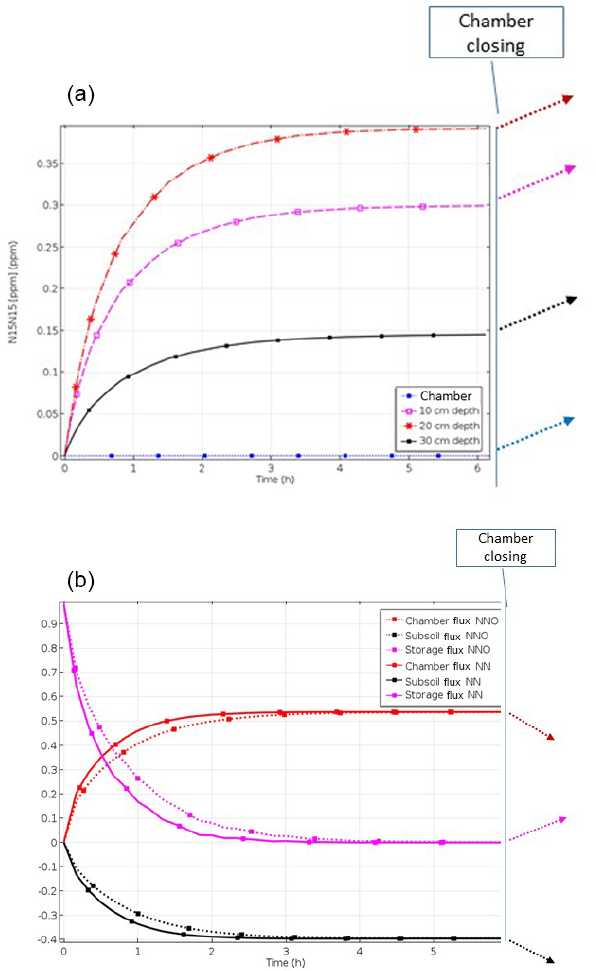
Figure 2. (a) Increase in pore space concentrations of N 2 evolved from the 15 N-labelled pool after start of denitrification, with open chamber when production of 15 N-labelled N 2 and N 2 O starts at constant rates, leading to accumulation of 15 N-labelled gases and thus build-up of concentration gradients to the surface and to the subsoil. Concentration trends following chamber closure are shown as dotted lines. (b) Time course of relative fluxes of N 2 and N 2 O evolved from the 15 N-labelled pool after start of denitrification, with open chamber showing increasing surface and subsoil fluxes while the storage flux decreases until steady state is reached. Trends of fluxes following chamber closure are shown as dotted lines.